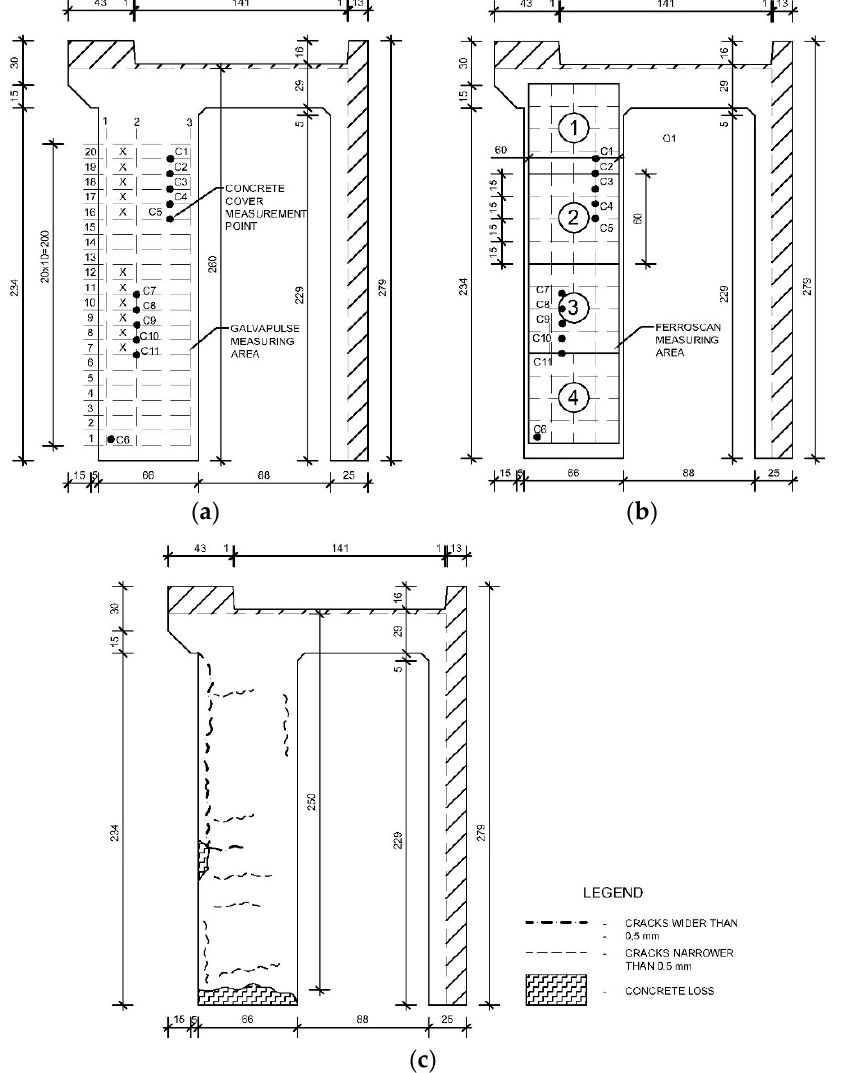
Figure 3. Test reinforced concrete wall, measuring areas: ( a ) GalvaPulse, ( b ) Ferroscan, and ( c ) crack pattern.